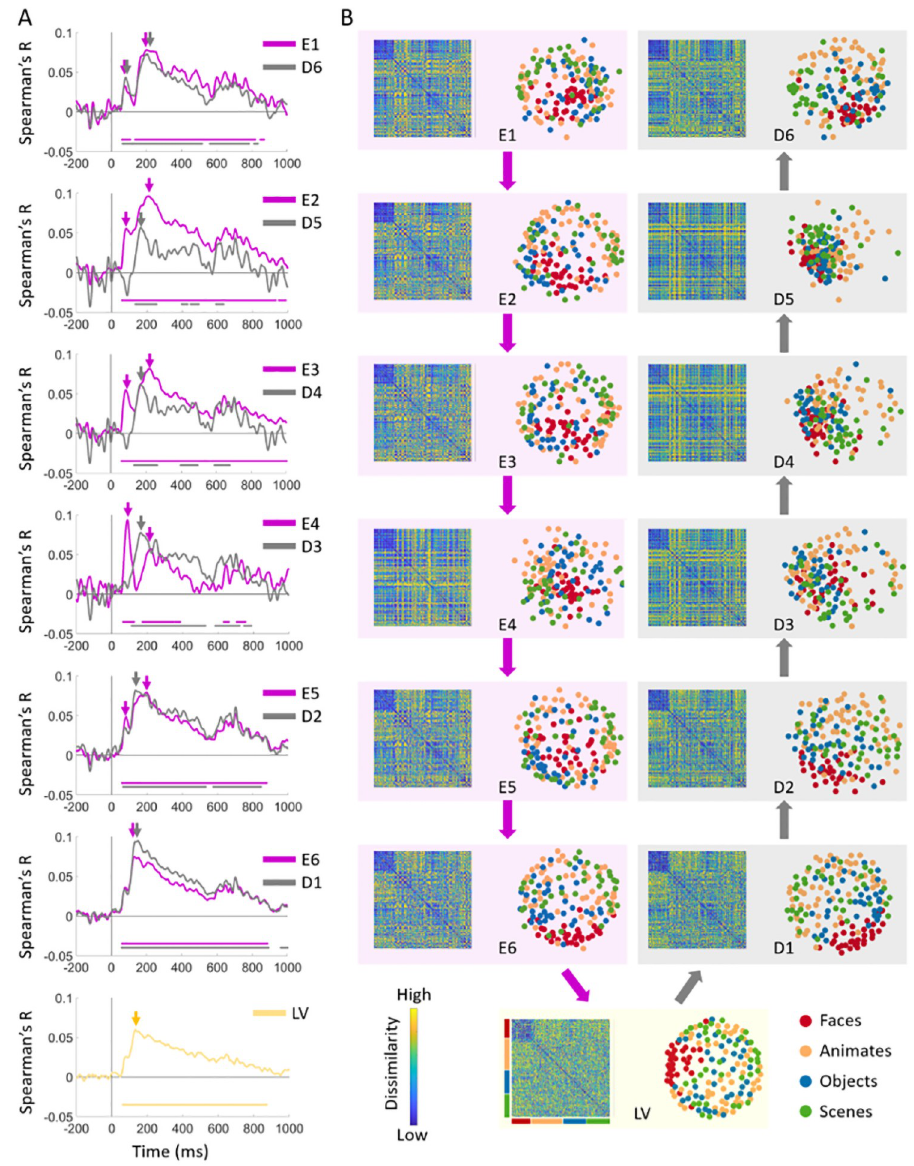
Fig 6. Comparisons of encoder and decoder representational dynamics. (A) Comparison of correlation time series of the encoder and decoder layers with the same level of processing. The color-coded lines below the curves show the timepoints when the correlations are significantly above zero (N = 15; permutation tests; cluster definition threshold P < 0.01; cluster threshold P < 0.05). (B) The model RDMs and their corresponding MDS